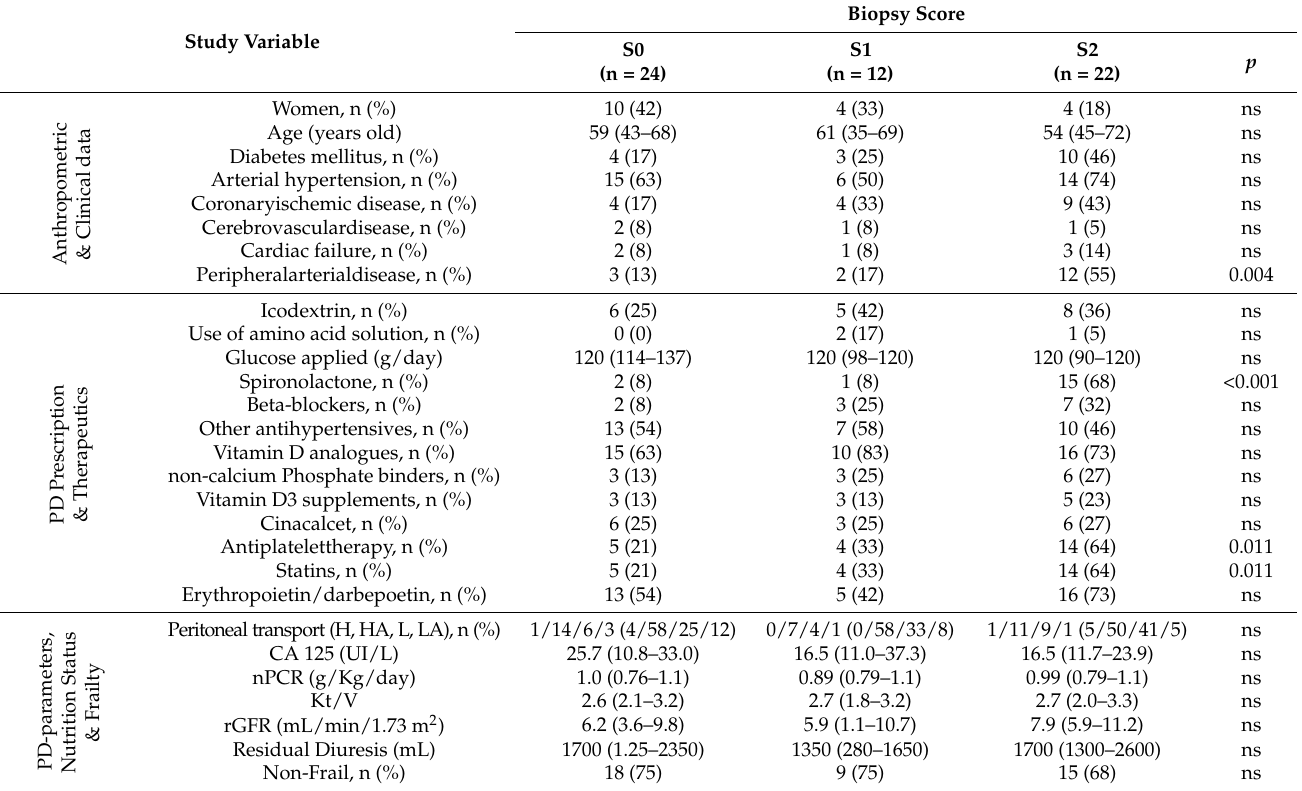
Table 1. Baseline variables of the study according to the biopsy score of the peritoneal membrane.